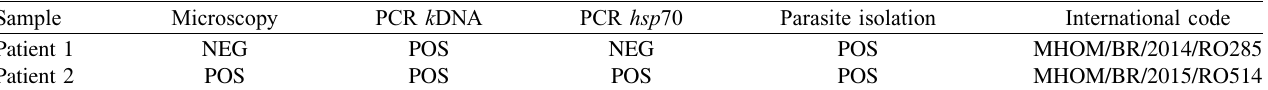
Table 1. Description of parasitological tests performed for samples collected in this study.